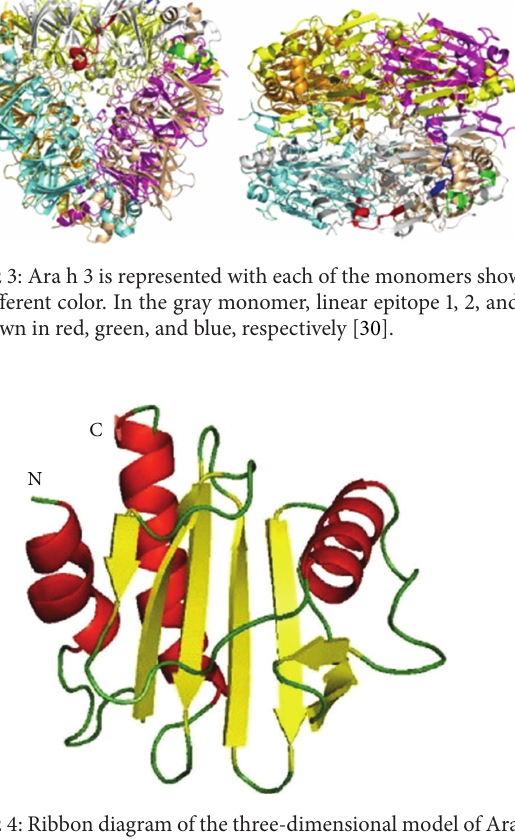
Figure 4: Ribbon diagram of the three-dimensional model of Ara h 5. Strands of b-sheet and stretches of a-helix are in yellow and red, respectively. Coil structures or loops are in green, N and C indicate the N- and C-terminus of the polypeptide, respectively